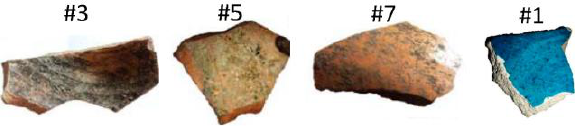
Fig. 1. Decorated pottery fragments withdrawn from the Agsu site.